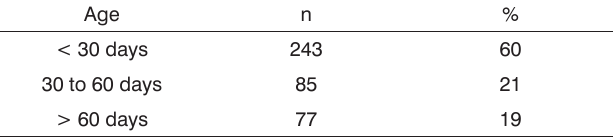
Table 2. Age (days) at which screening tests were carried